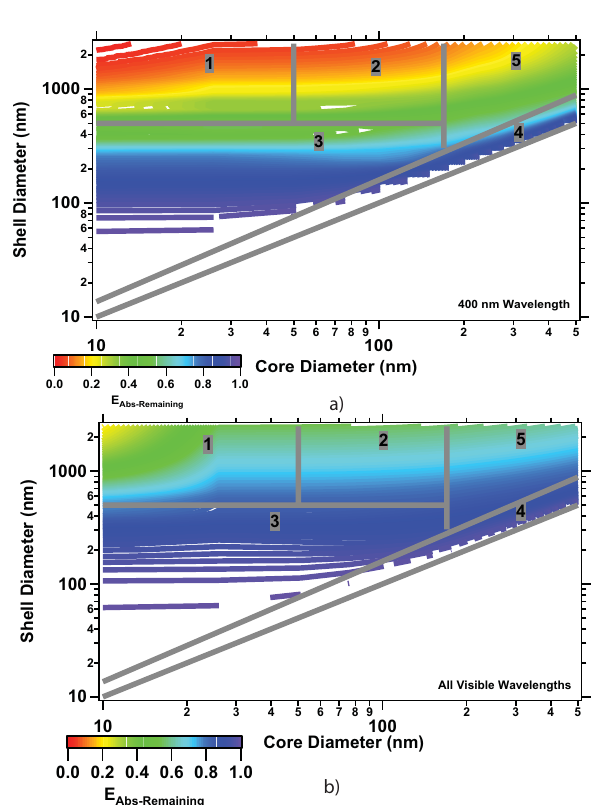
Fig. 4. (a) Calculated E Abs − Remaining for different BC core and C Brown shell diameters at 400nm wavelength. Regime numbers from Bond et al. (2006) and position of central values used for these regimes also shown. (b) Same as (a) but integrated over all visible light